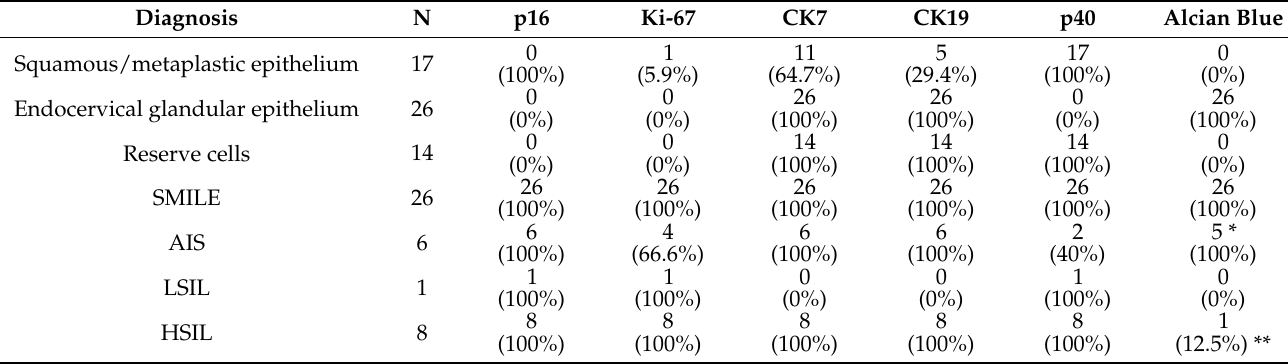
Table 3. Results of immunohistochemical staining for p16 (diffuse block nuclear and cytoplasmic positivity), Ki-67 (increased expression), CK7 (cytoplasmic positivity in >50% cells), CK19 (cytoplasmic positivity above basal layer in >50% cells), p40 (nuclear positivity) and staining for mucin by Alcian